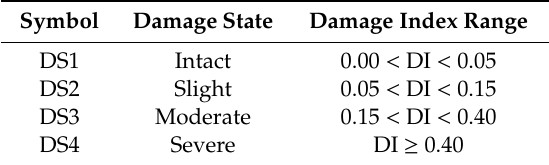
Table 4. Damage-based classification of damage states for gravity